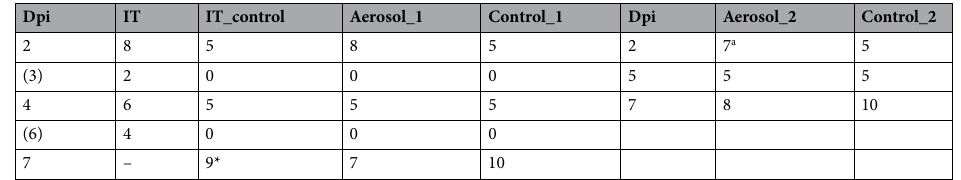
Table 4. Time of euthanasia following inoculation. Number of birds in each group euthanised at the given dpi. Days presented in brackets were not prescheduled days for euthanasia, however, birds were culled due to severe clinical signs. a From the Aerosol_2 group, one animal died spontaneously from severe, acute septicaemia confirmed by florid growth of E. coli from the bone marrow. *The intratracheal control group contained a lower overall number of birds, as one had to be euthanised shortly following arrival due to a severe case of chronic pododermatitis. dpi. days post-infection, IT